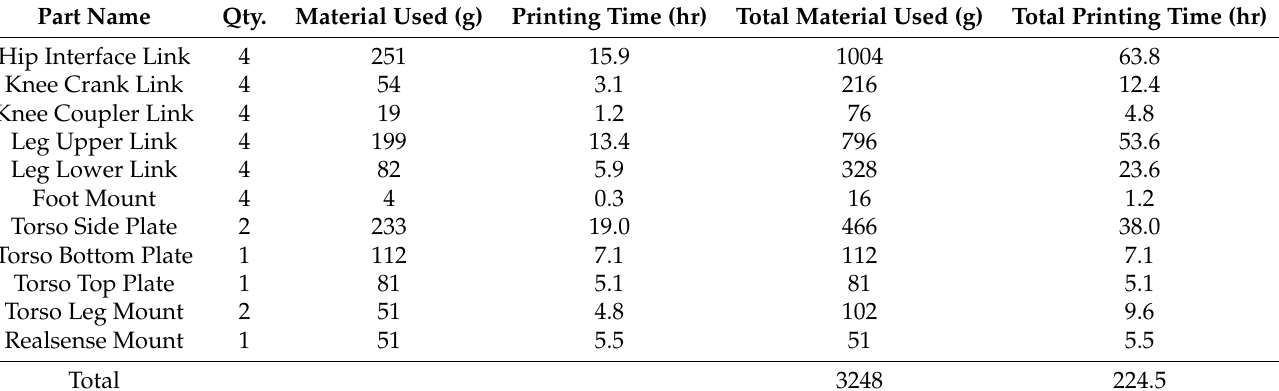
Table 3. Summary of 3D printing results.